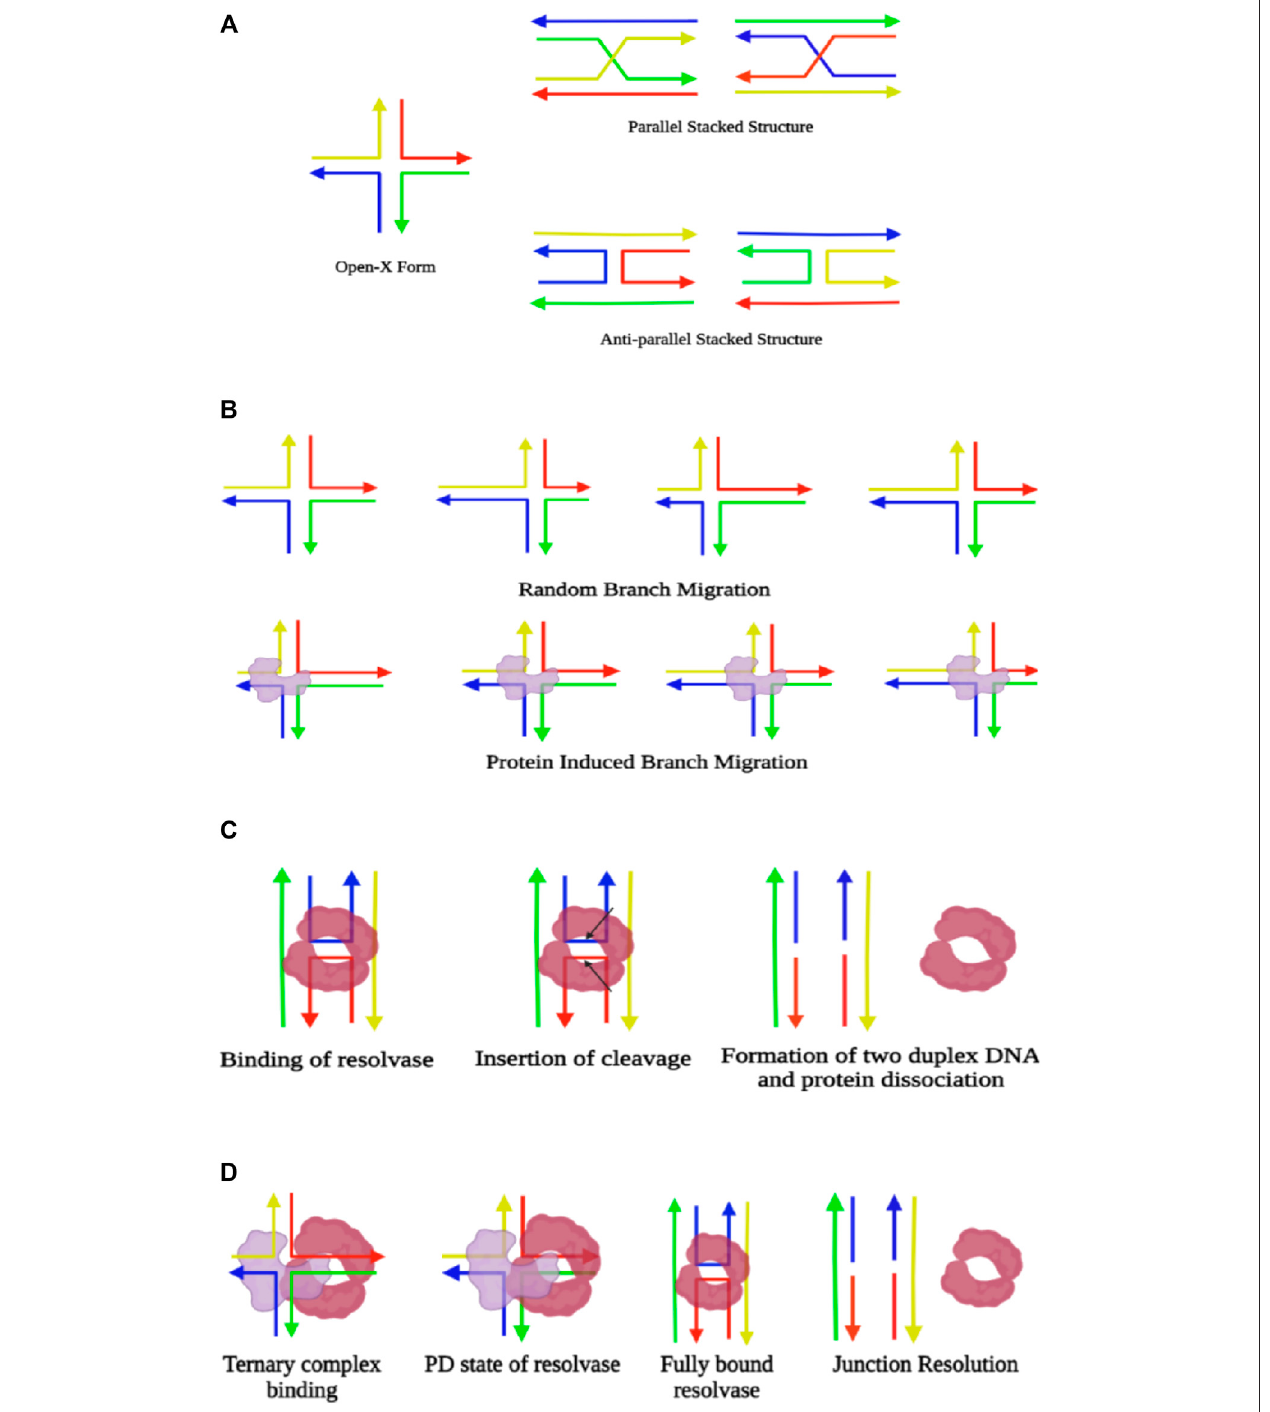
FIGURE 3 | (A) Illustration of different forms of Holliday junctions. (B) Schematic representation of branch migration, where there is random locomotion of the junctionduringspontaneousbranchmigration.However,thepresenceofproteininthejunction(coloredinblue)leadstodirectionalbranchmigration. (C) Representation of junction resolution through enzymes. Resolvases (colored in maroon) bind the dimeric form at the junction and insert two symmetrical cleavages (indicated by the arrows), which fi xes the four-way junction and gives rise to two duplexes, followed by the dissociation of the protein. (D) Demonstration of simultaneous branch migration and Holliday junction resolution. The resolvase and branch migratory enzyme initially form a ternary complex and bind at the junction where the resolvase remains in apartiallydissociated state (PDstate). Upon branch migration up tothe required cleavage site, the resolvaseconvertsitself toa fully bound state and induces the desired nicks for junction resolution (created with